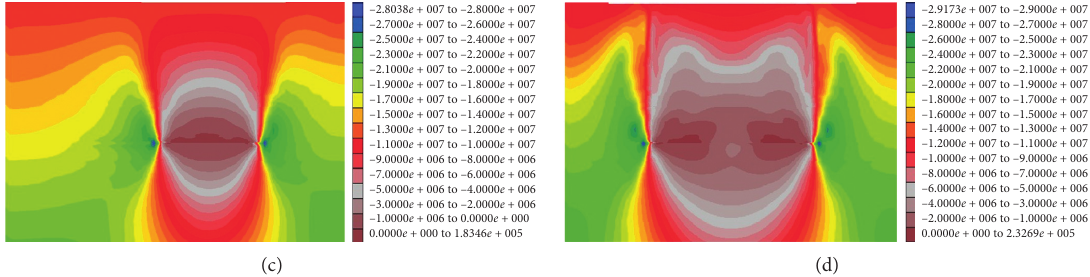
Figure 4: Vertical stress distribution along retreat direction at various retreat stages. (a) Vertical stress distribution along retreat direction after retreating 40m. (b) Vertical stress distribution along retreat direction after retreating 80m. (c) Vertical stress distribution along retreat direction after retreating 120 m. (d) Vertical stress distribution along retreat direction after retreating